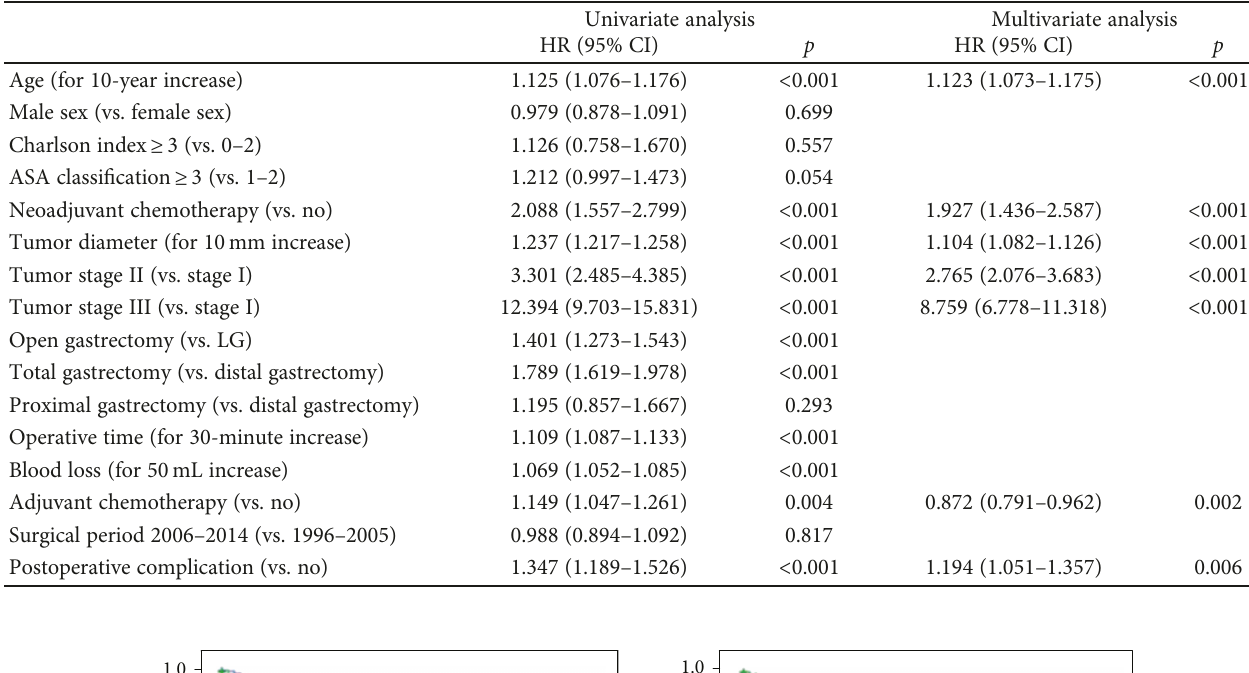
Table 3: Univariate and multivariate analyses for disease-speci fi c survival in patients after curative resection of gastric cancer.